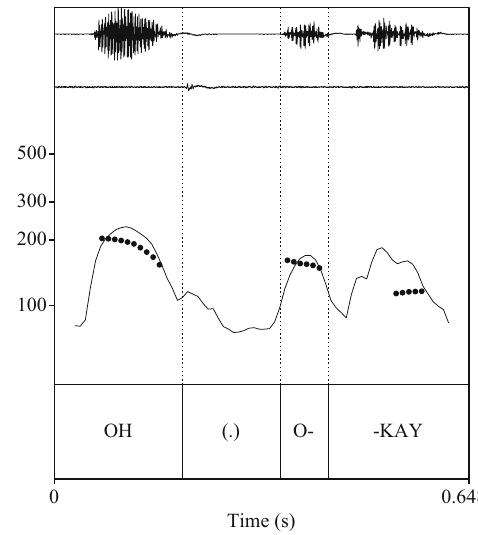
Figure 1: Pitch trace and intensity curve for lines 07 – 08 in Ex. ( 5 ) “ New job ”